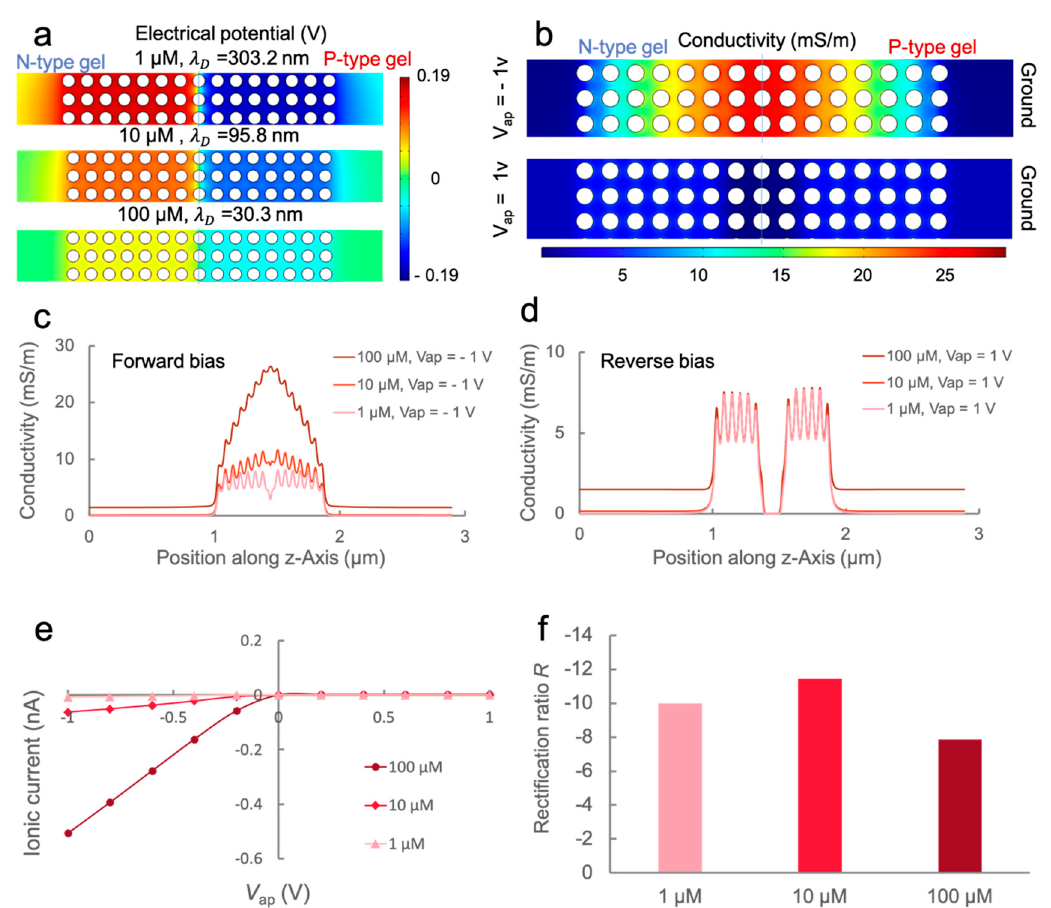
Figure 3. Simulation of the effect of ionic strength on ion transport in PHID: ( a ) Electrical potential distribution in the hydrogel heterojunction for various ionic strengths, no external electric field is applied; ( b ) conductivity profile in the hydrogel junction at different external bias polarities at the ionic strength of 100 µ M; ( c , d ) plots of ionic conductivity along the center z-axis (AD in Figure S1) for various ionic strengths under a ( c ) forward bias and ( d ) reverse bias, respectively; ( e ) I-V characteristics of the entire hydrogel junction at various ionic strengths; ( f ) rectification ratios of the hydrogel junction obtained from respective I-V curves.